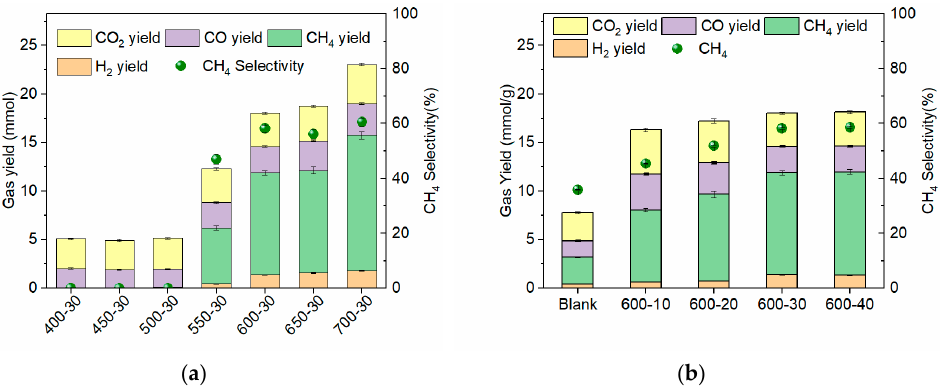
Figure 7. Influence of temperature and time on the gas yields. ( a ) Temperature, ( b ) Time.